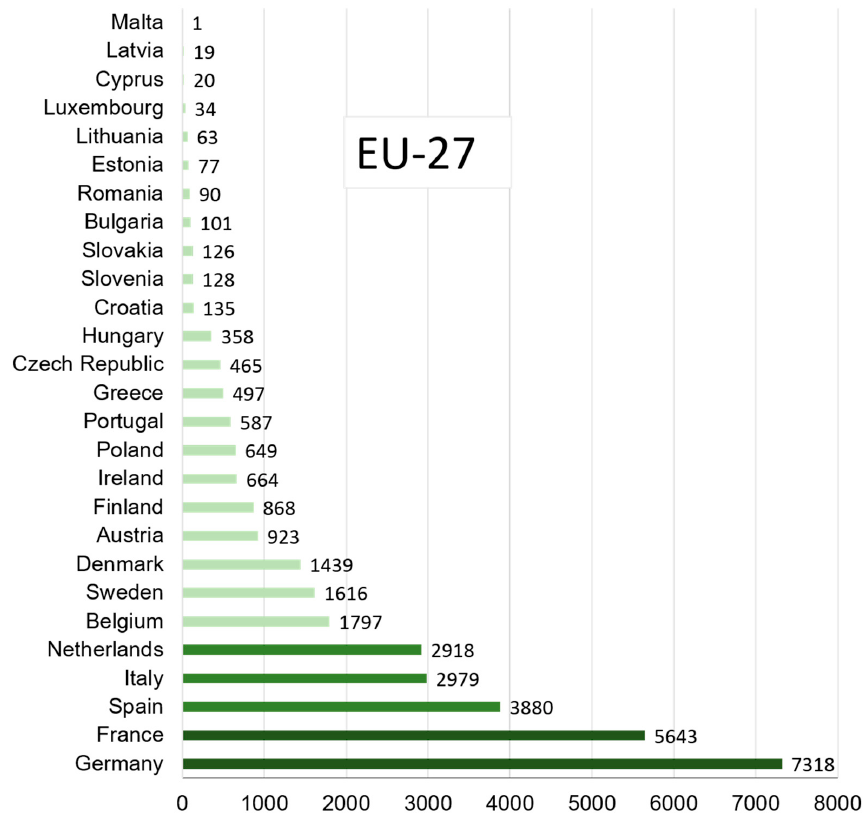
Figure 4. EU-27 publications cited in patents.